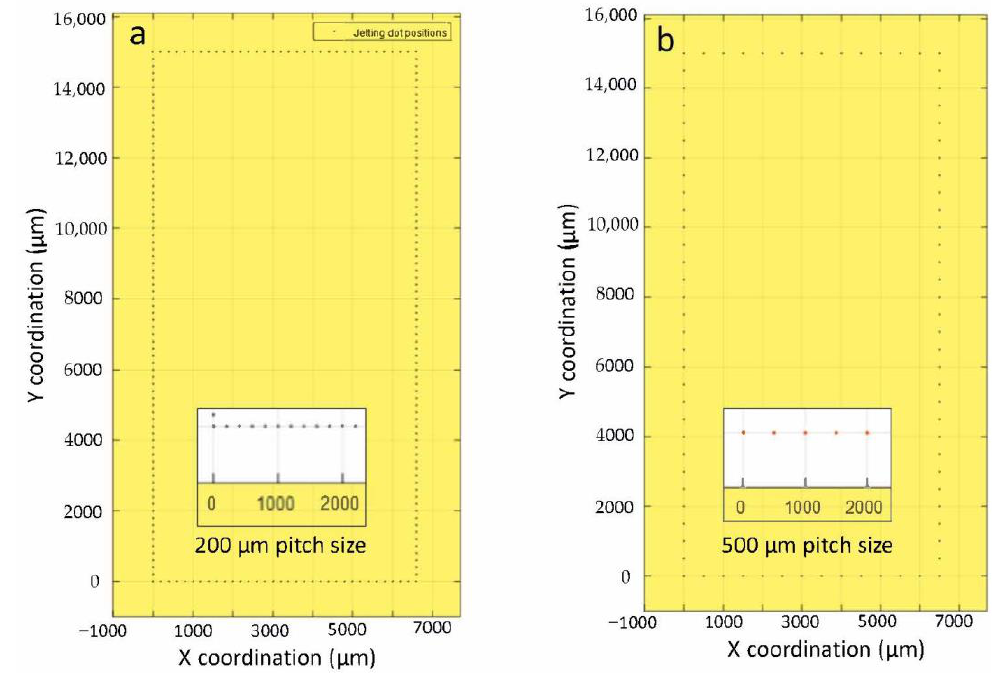
Figure 4. Two examples of the CAD files for jetting of the glass frit as a bond frame in two resolutions, i.e., 200 µ m pitch size ( a ) and 500 µ m pitch size ( b ). Here the pitch size is the center-to-center distance between two droplets.